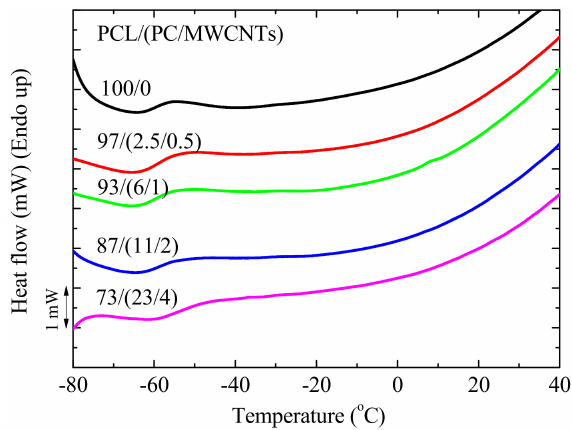
Figure 4. DSC heating curves for neat PCL and the PCL/(PC/MWCNT) nanocomposites, showing the glass transitions around − 60 ◦ C.